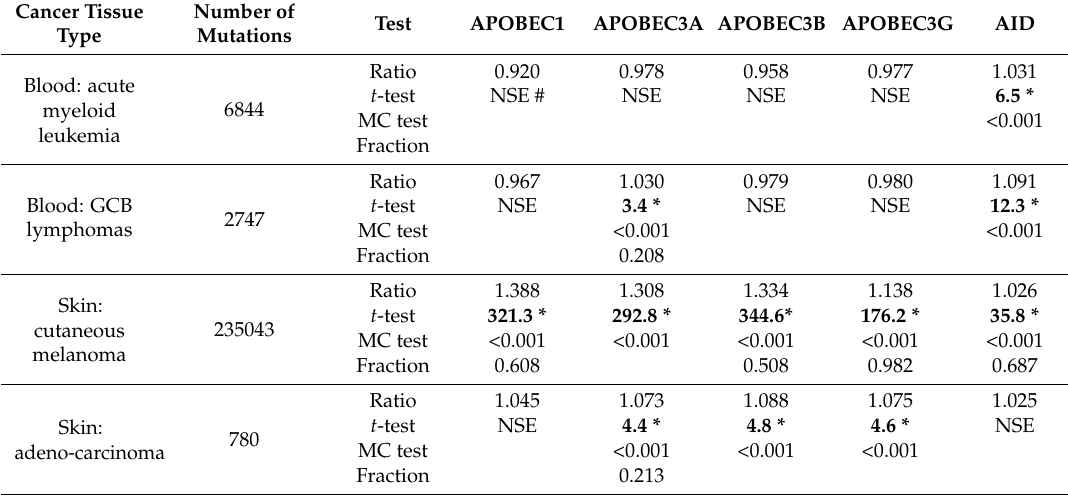
Table 2. Correlation between AID/APOBEC mutable motifs and the context of somatic mutations in C:G sites in various blood and skin tumor